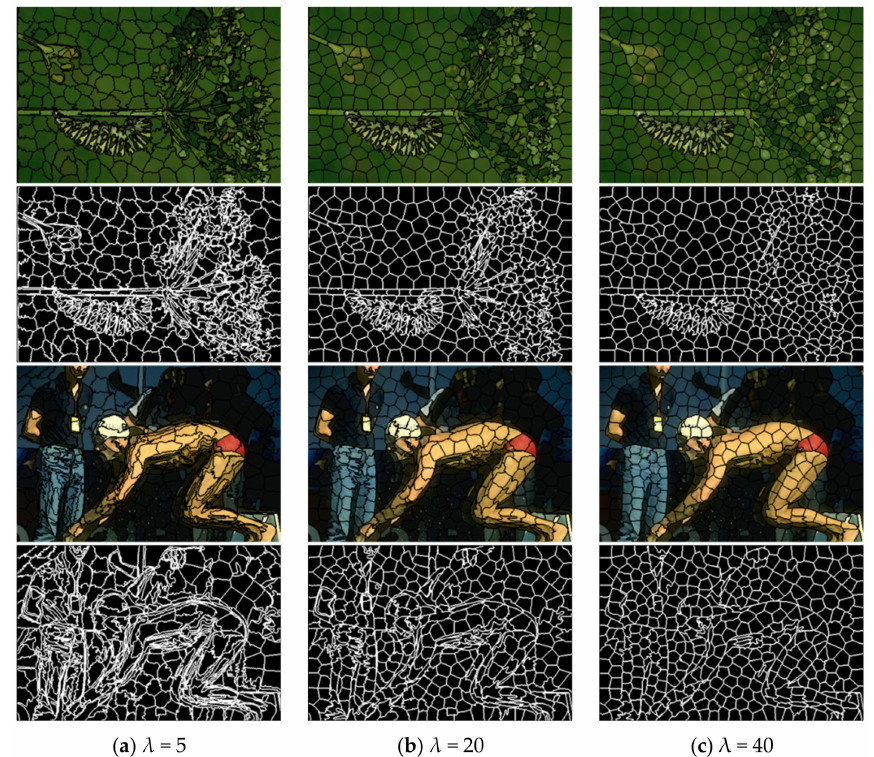
Figure 5. Superpixel segmentation results with di ff erent λ